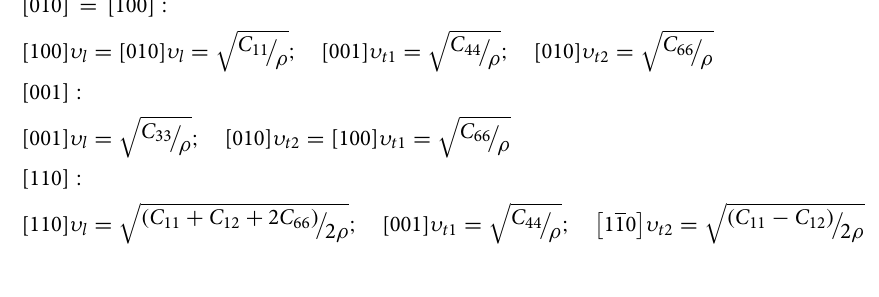
G /ρ 3 (m 4 /kg s) of TaP and TaAs (cid:31)